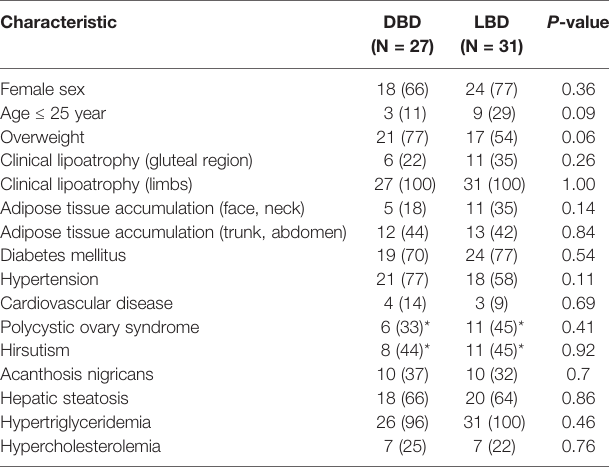
TABLE 1 | Clinical data of FPLD3 patients from previous studies. Characteristic